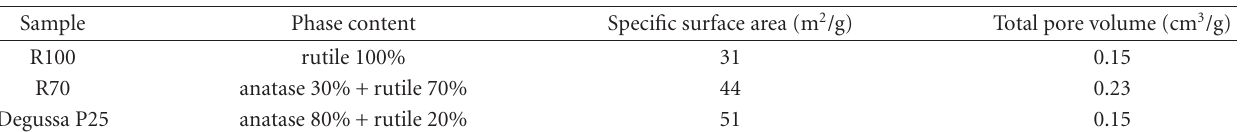
Table 1: XRD and N 2 adsorption-desorption results for the pure rutile (R100) and mixed-phase (R70) TiO 2 , synthesized in the present study, compared with Degussa P25.